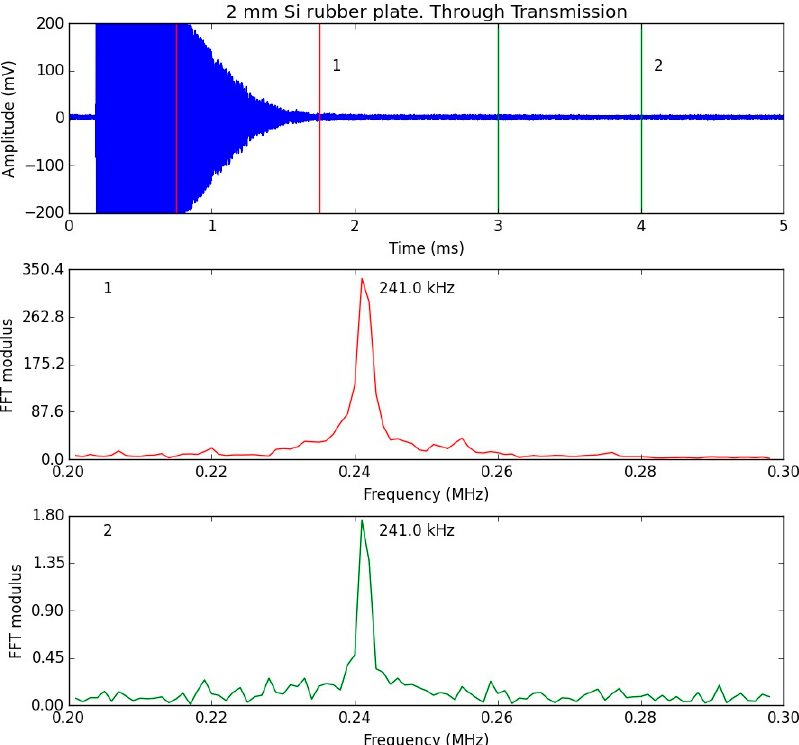
Figure 5. Through-transmission in the 13.5 mm-thick aluminum plate. Top: signal in the time domain. Center: FFT modulus of the signal within window (1). Bottom: FFT modulus of the signal within window (2).